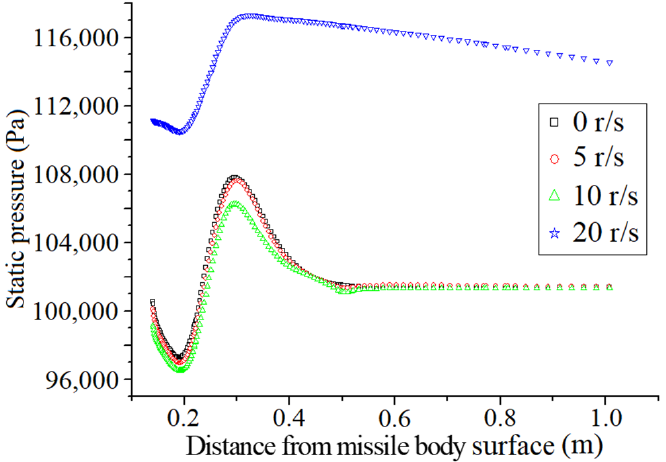
Figure 12. Static pressure distribution at x-axis at different rotational angular velocities.